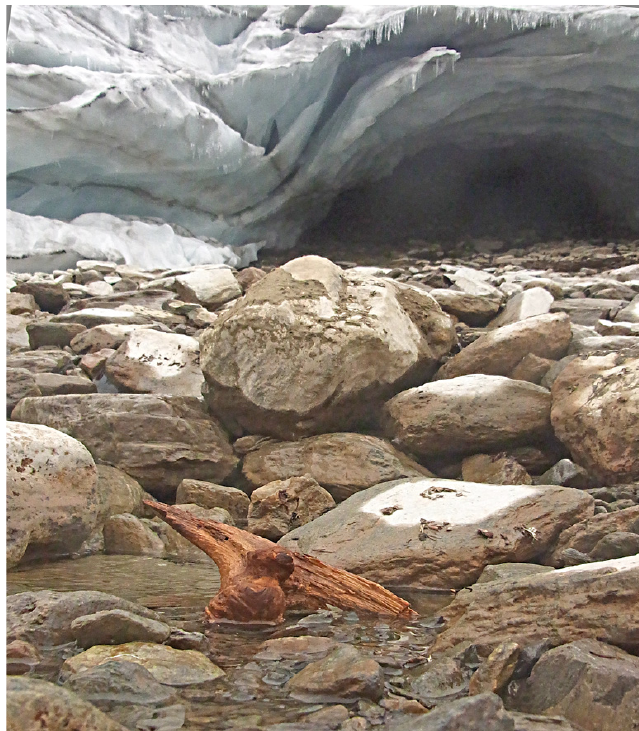
Figure 18: Kåppasglaciären (11). Wood remnant of pine, expo-